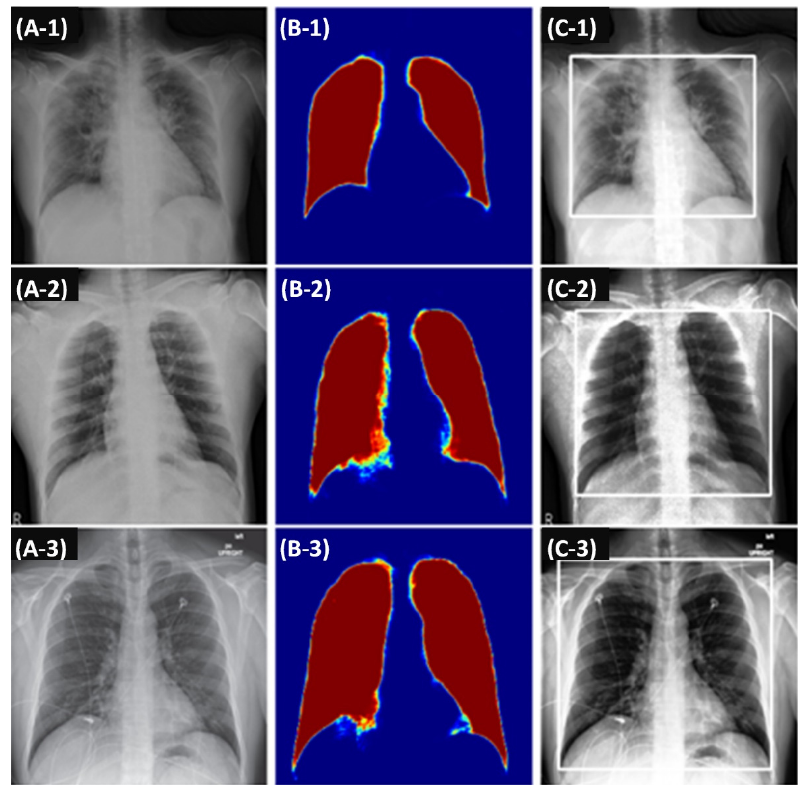
Figure 2. Lung region detection component applied on example CXRs. First column ( A-1 to A-3 ): example chest radiographs; middle column ( B-1 to B-3 ): predicted lung probability maps; third column ( C-1 to C-3 ): lung regions in bounding boxes suitable to process in a convolutional neural network.